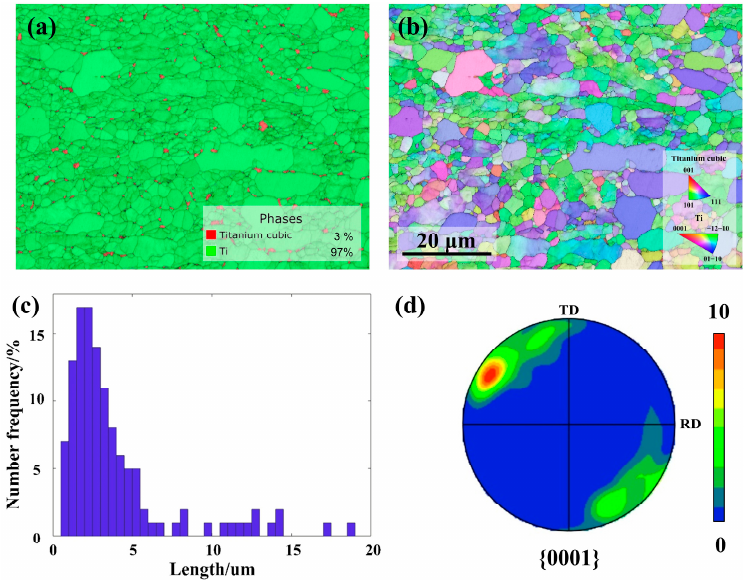
Figure 2. Initial microstructure of the Ti-6Al-4V. ( a ) Phase distribution map (Green for α and red for β phase). ( b ) EBSD inverse pole figure (IPF). ( c ) Grain size distribution map of the α phase. ( d ) {0001} pole figure (PF).